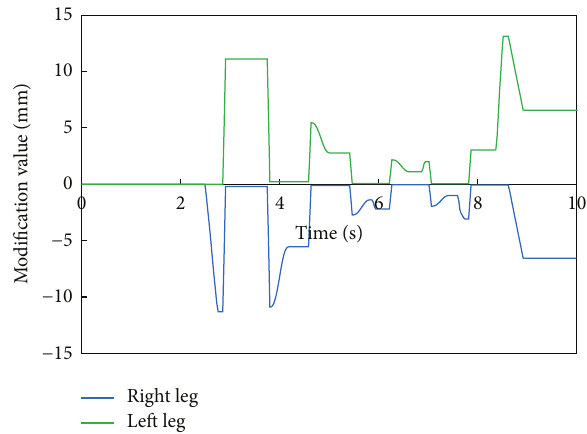
Figure 12: Modification value of a swing foot along the lateral axis with 30 mm breadth feet.